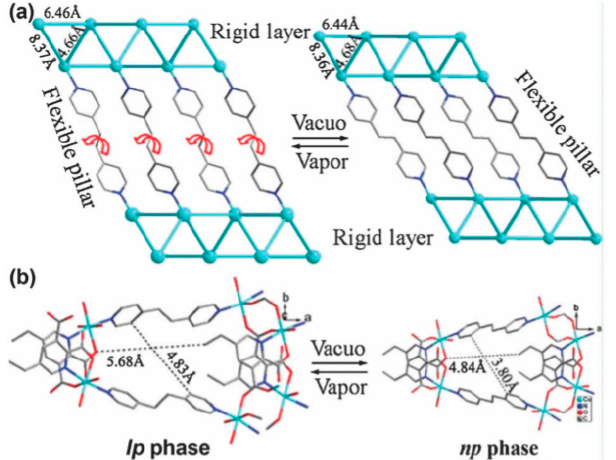
[108]. Copyright © 2009, Royal Society of Chemistry. All rights reserved.